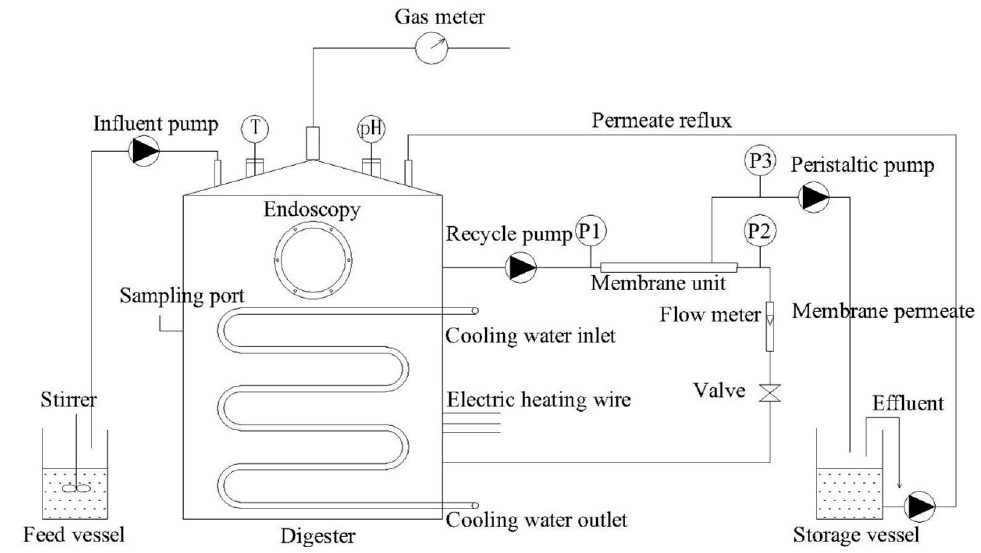
Figure 1. Schematic diagram of the AnMBR reactor.